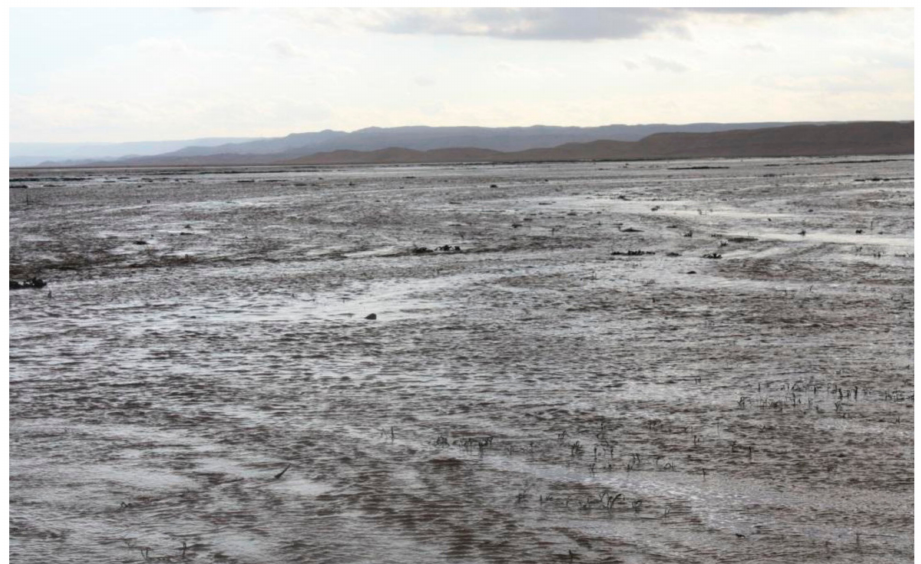
Figure 2. The El-Sa’edin Playa (Qa el-Sa’edin) under inundation. The picture was taken on 31 January 2013 by Boaz Langford. Reproduced with permission from the